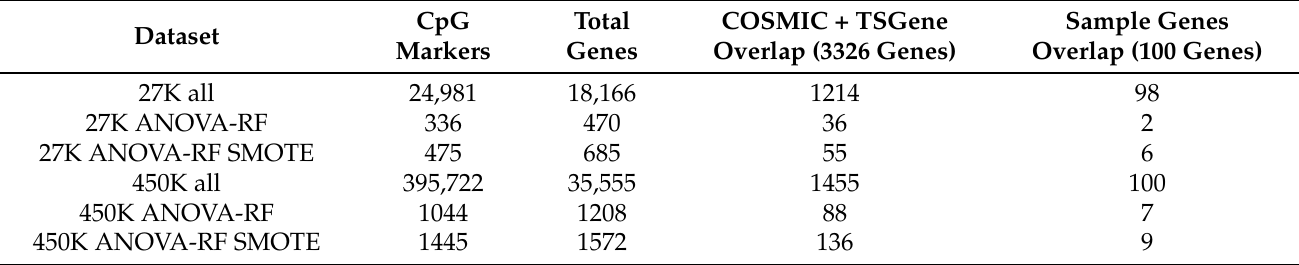
Table 4. Evaluation of selected oncogenic and tumor suppressor associated gene sets identified to be associated with breast